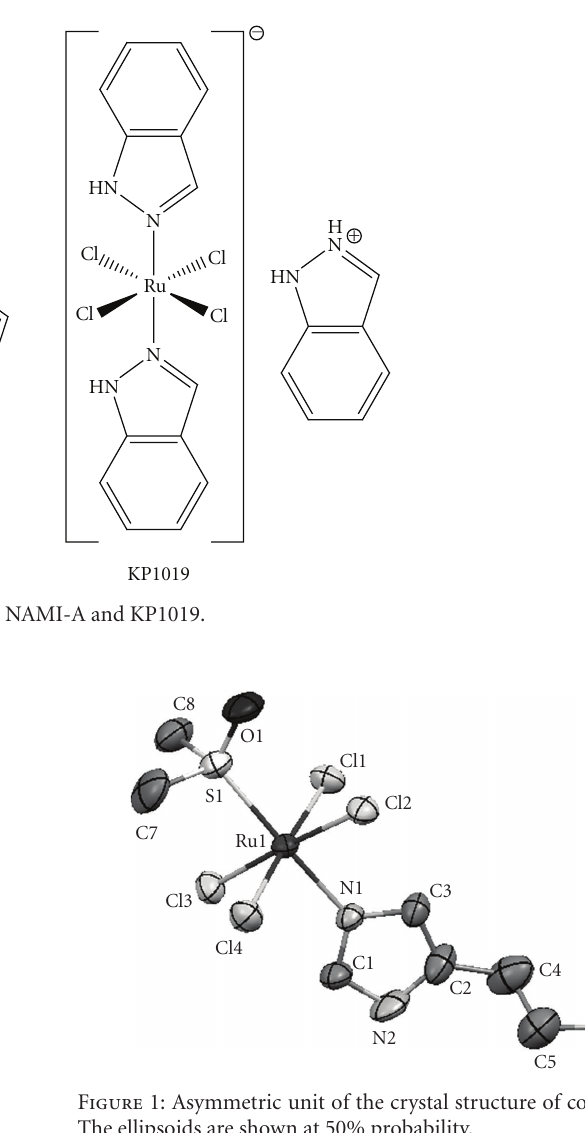
Figure 1: Asymmetric unit of the crystal structure of complex 1b . The ellipsoids are shown at 50%